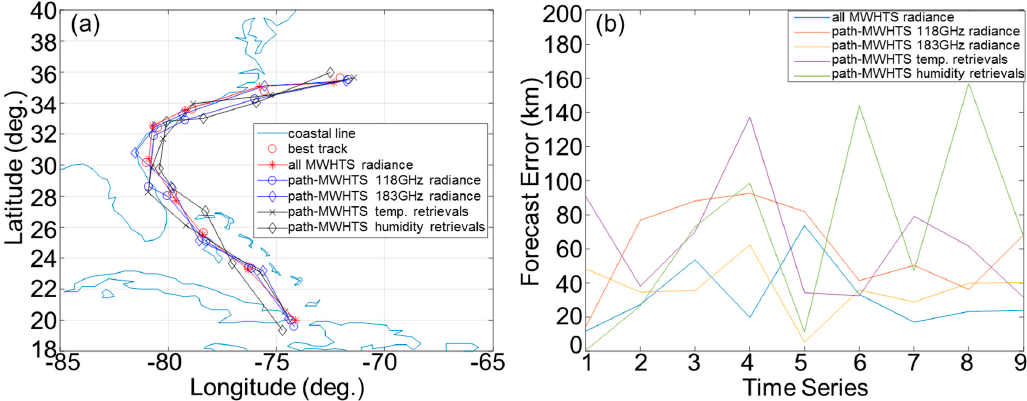
Figure 12. ( a ) Comparison between forecast track and best track of hurricane Matthew; and ( b ) bias of the forecast paths.